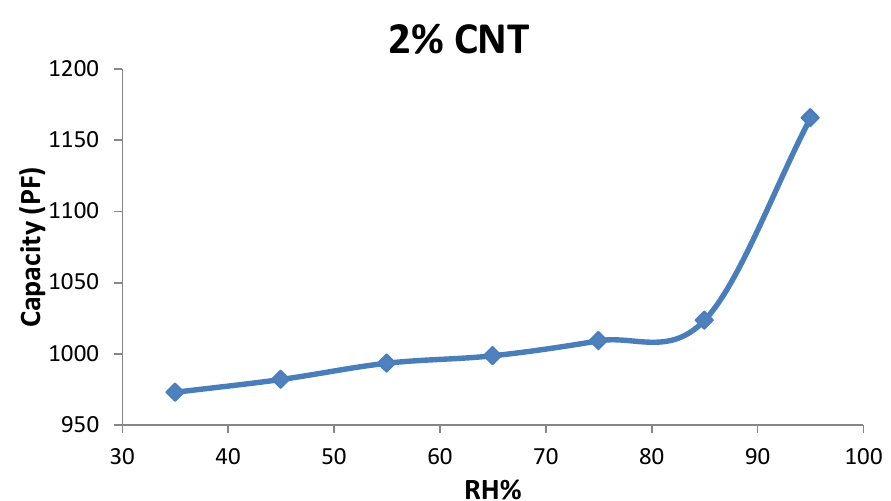
Fig.5: Humidity capacitance relationship for humidity sensors 2% MWCNT.